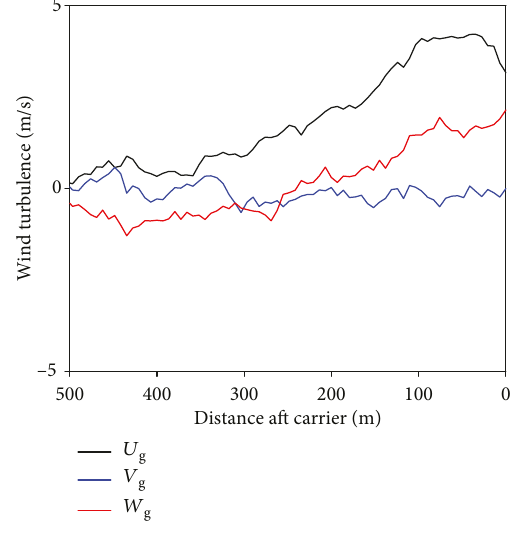
Figure 7: Wind turbulence components.